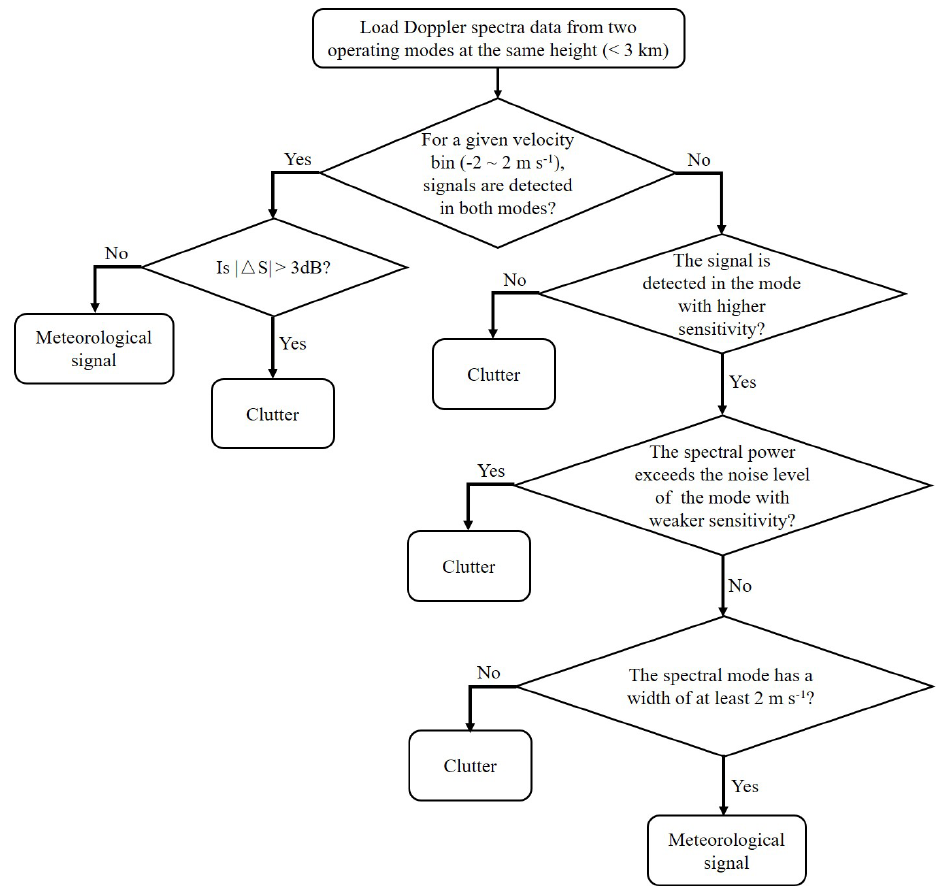
Figure 3. Flowchart of the proposed clutter identification and mitigation